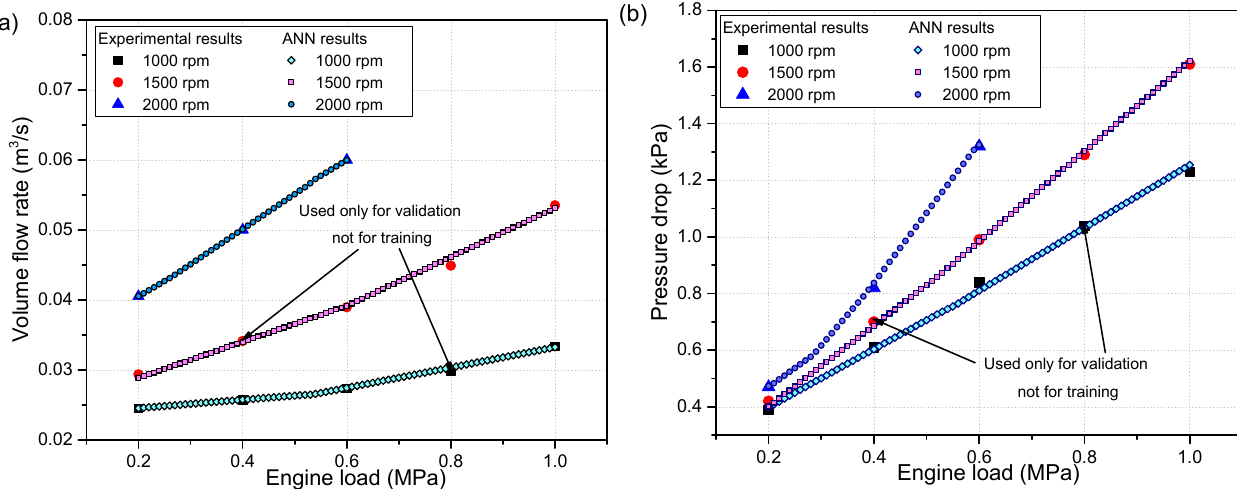
Figure 6. Fluid flow characteristics of the developed TEG: ( a ) volumetric flow rate of the exhaust gas passing through the TEG, and ( b ) pressure drop across the TEG as a function of the engine load and rotation speed.